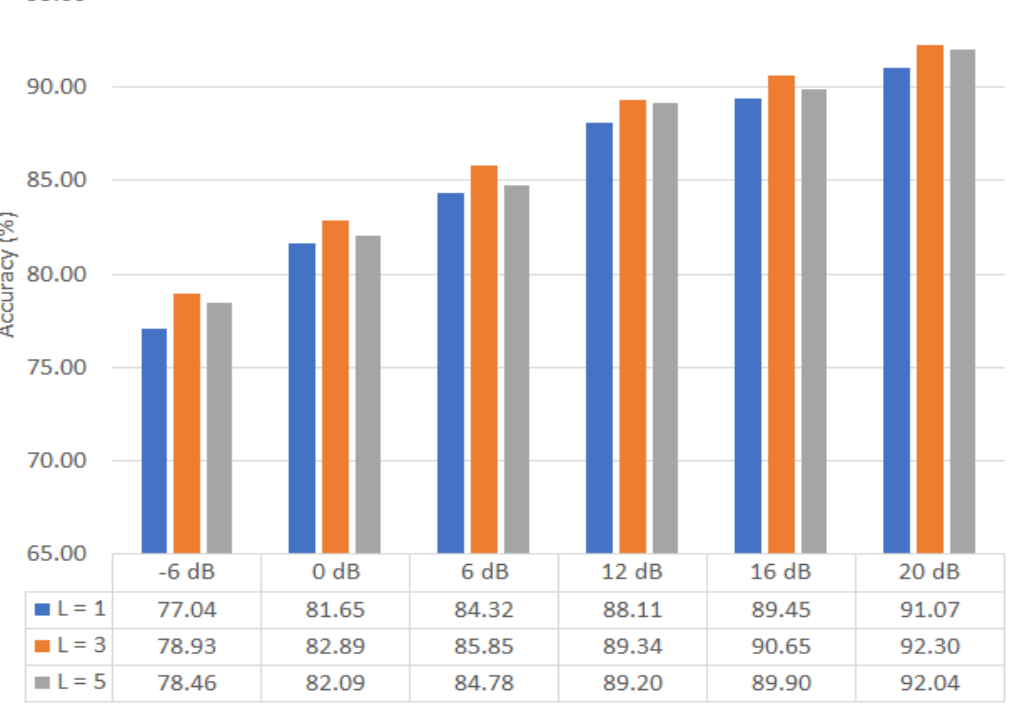
Figure 4. The classification accuracy (in percentages) of the acoustic wood logging utilizing the postprocessing for the best performing support vector machine (SVM) classifier.